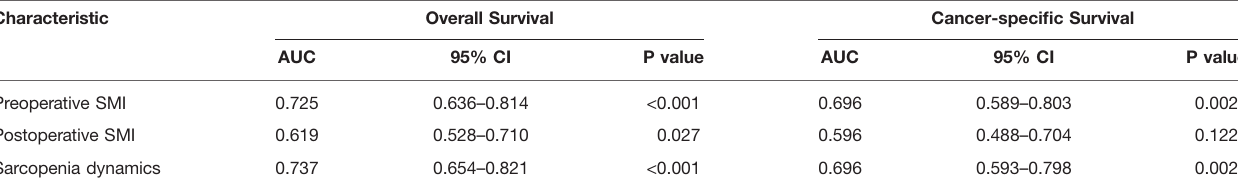
TABLE 3 | Analysis of predictive accuracy through the evaluation of the area under the curve (AUC).